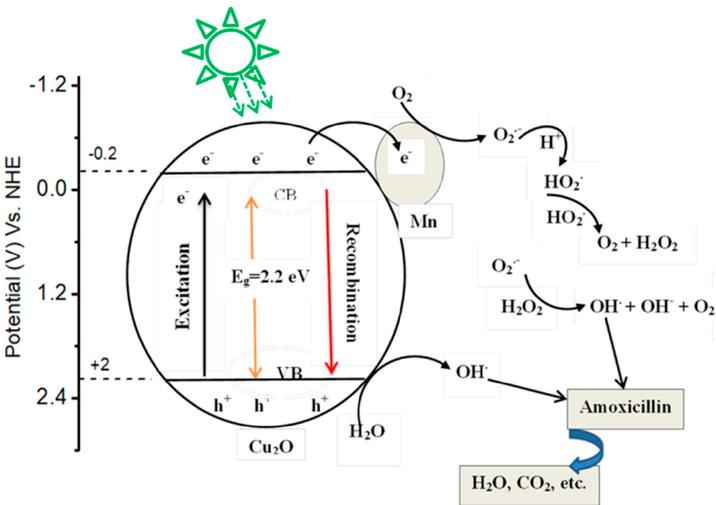
Figure 9. Proposed mechanism for the photocatalytic degradation of amoxicillin using Mn-doped Cu 2 O nanoparticles under solar light irradiation.